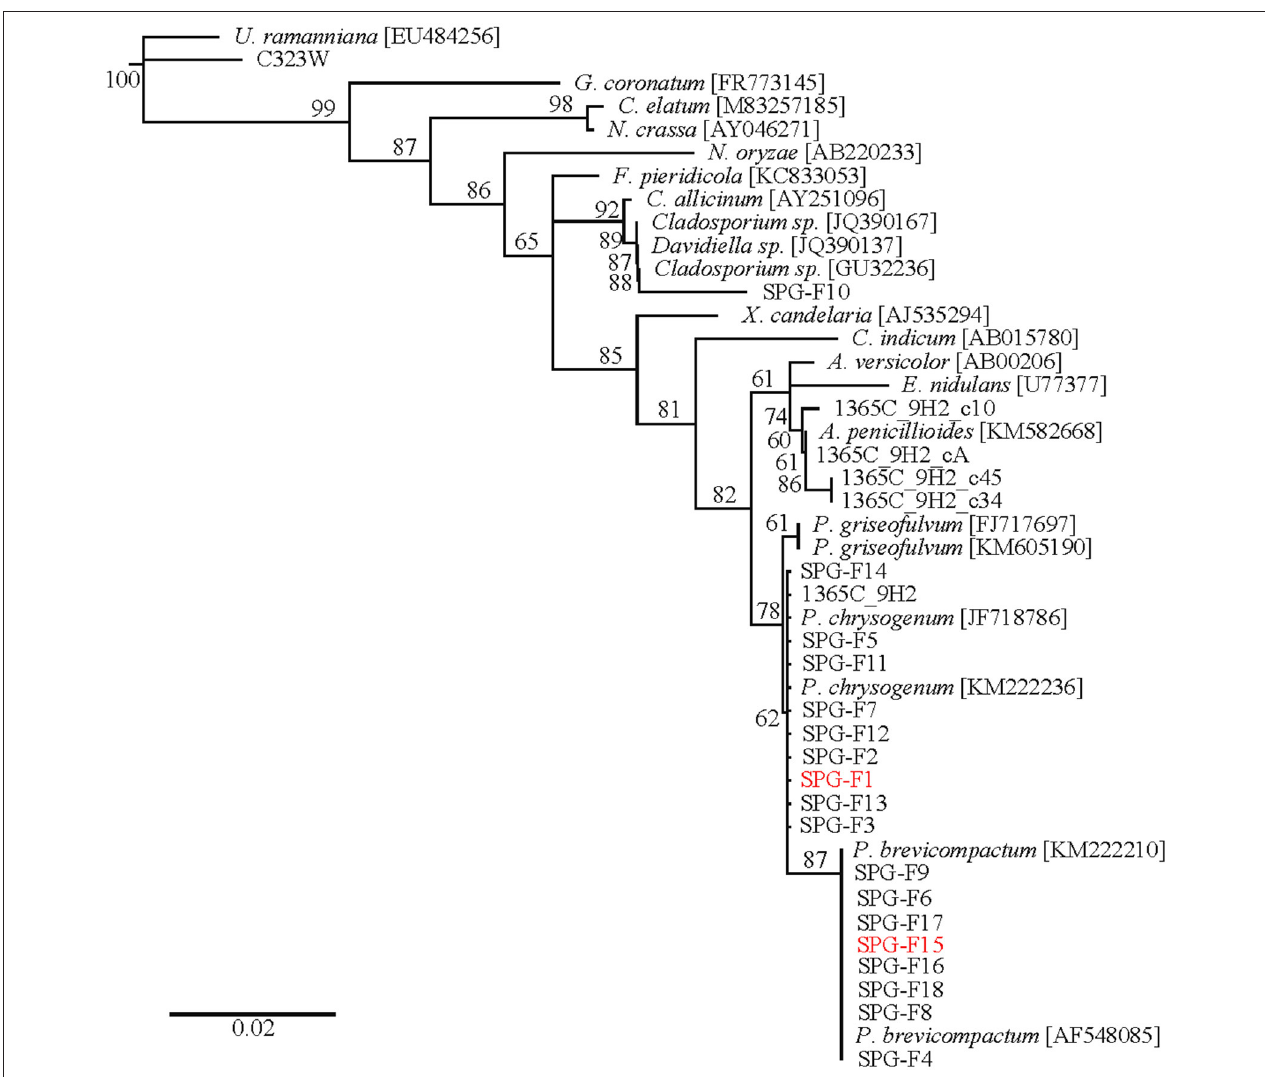
FIGURE 3 | Phylogenetic tree of 18S rRNA gene sequences from clones and isolates from the South Pacific Gyre